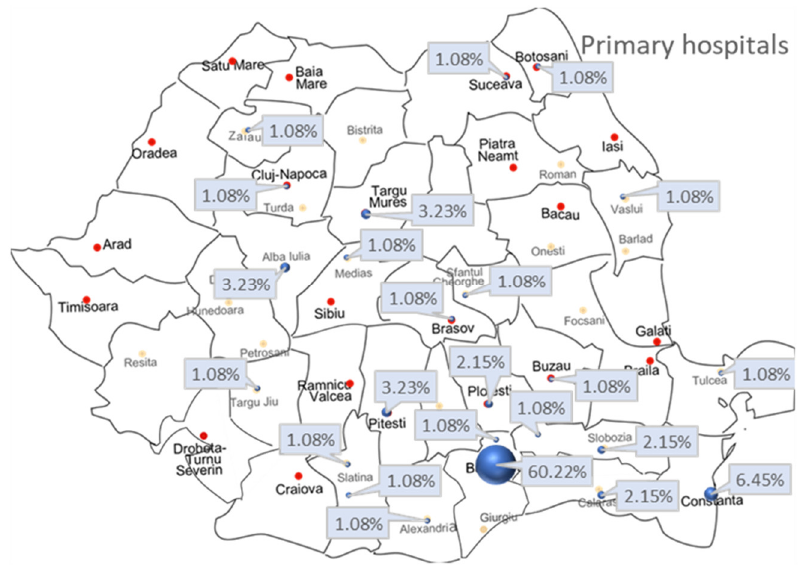
Figure 2. Patients’ distribution according to the primary hospital of admission.